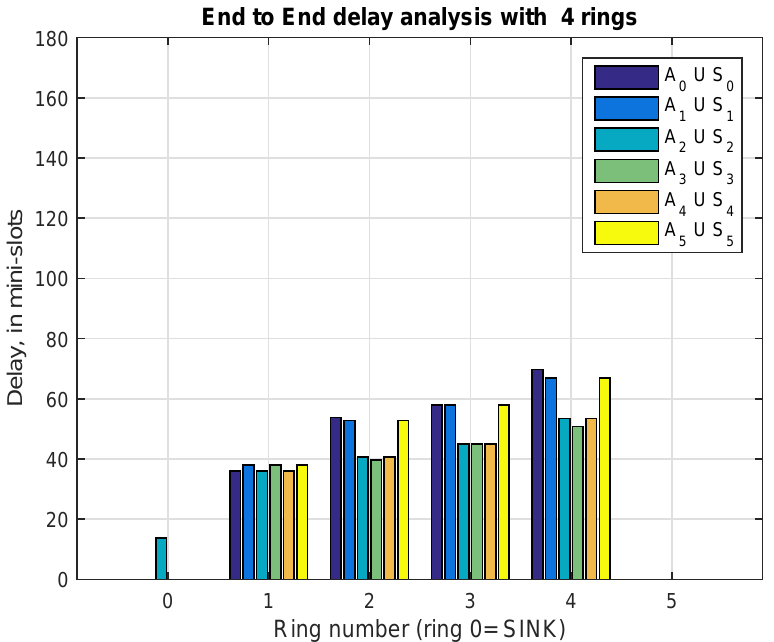
Figure 10. End to end delay (in mini-slots), from sensor to the sink, for r max = 4, p act = 0.001 and ( N ) = ( 2,3;1,7 ) msC , N intra ; N msT , N inter